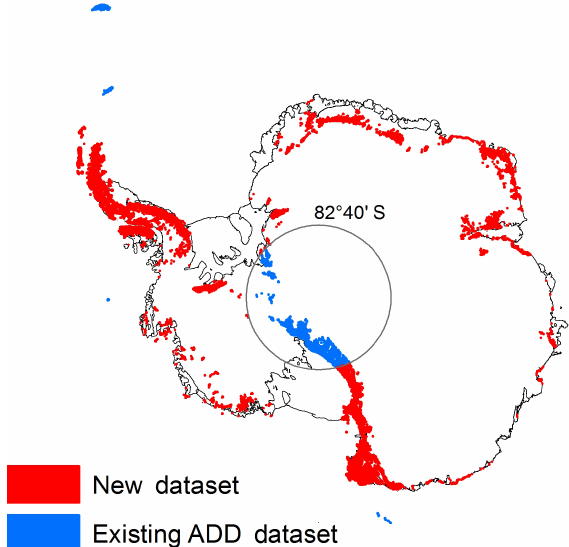
Figure 7. Rock exposure map of Antarctica showing the data sources for the new dataset. Outcrops shown in red were derived using the new remote-sensing methodology, and outcrops in blue were derived from the existing ADD rock outcrop dataset to sup- plement areas not covered by the Landsat 8 imagery (areas south of 82 ◦ 40 (cid:48) S or islands lacking suitable cloud-free images). Areas of rock exposure are exaggerated for